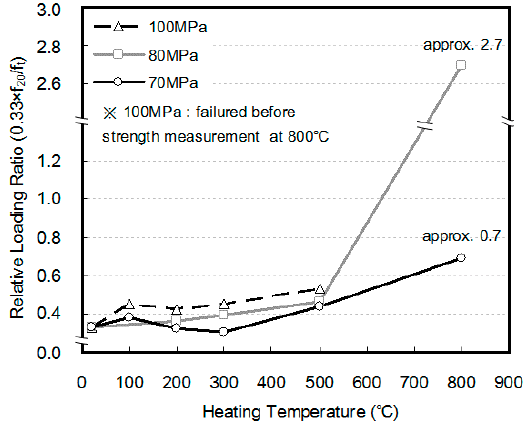
Figure 8. Relative loading ratio of HSC.